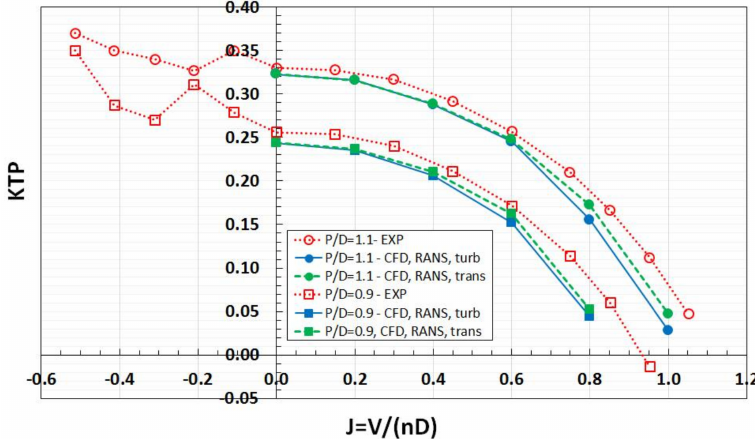
Figure 7. Measured (red) and computed (blue—fully turbulent model, green—transition model) propeller thrust, KTP, at the two propeller pitch settings, P/D, and different loading conditions.